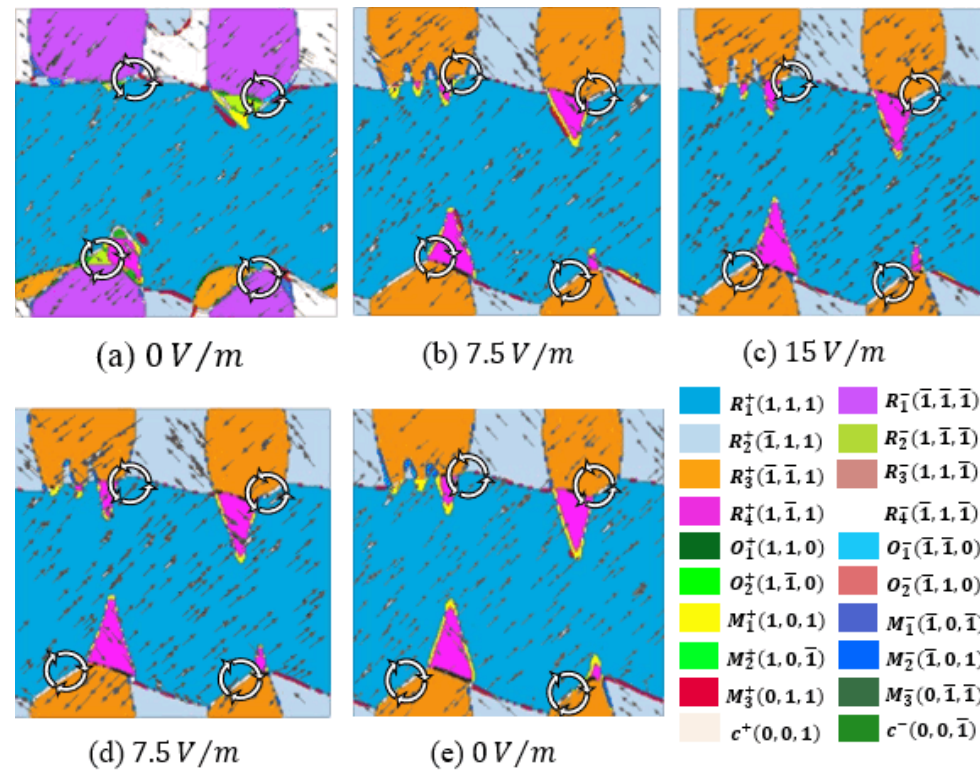
Figure 2. The domain evolution of K 0.5 Na 0.5 NbO 3 thin films under different electric conditions. ( a ) Without electric field. ( b , c ) Loading electric field. ( d , e ) Unloading electric field.